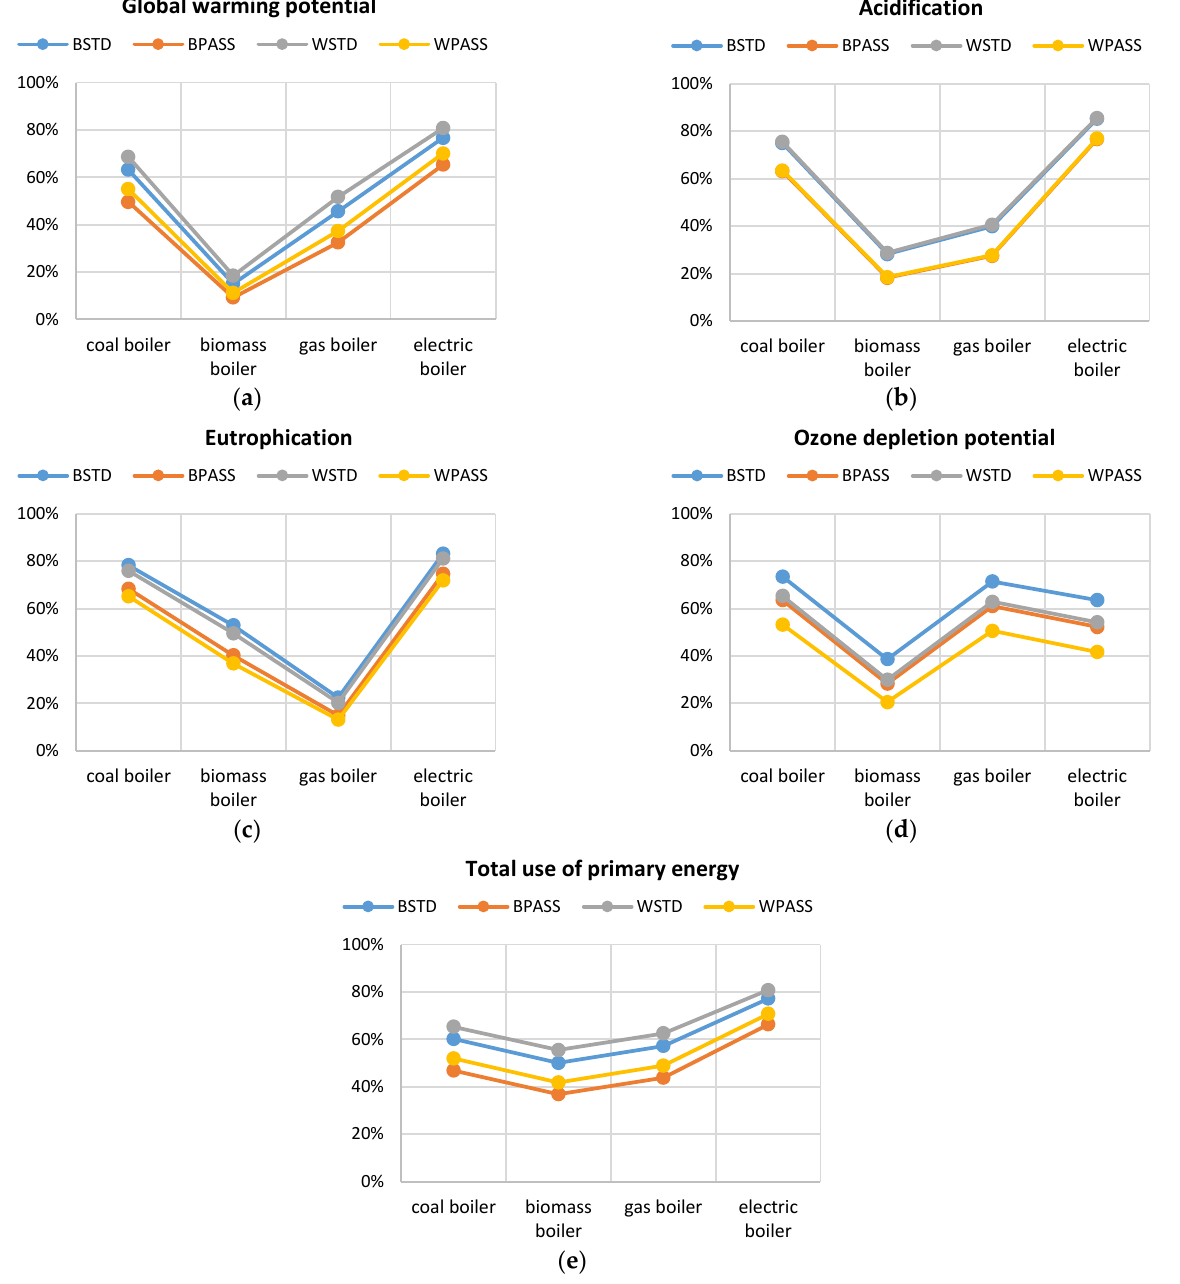
Figure 10. Percentage ratio of the operational stage (heating) stage in the life cycle: global warming potential ( a ), acidification ( b ), eutrophication ( c ), ozone depletion potential ( d ), and total primary energy use ( e ).